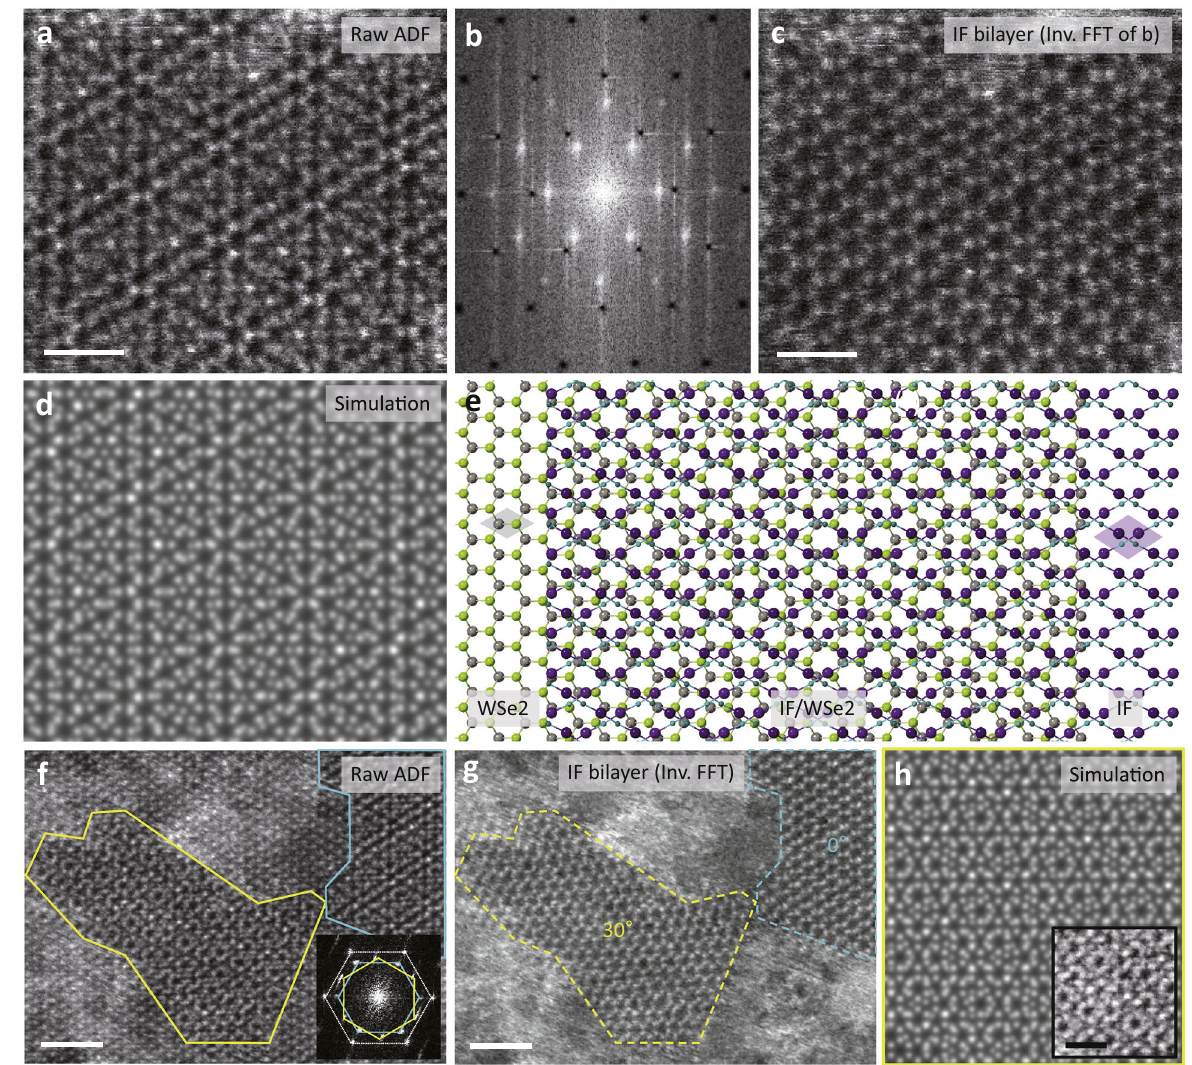
Fig. 3 Structure and stacking order of 2D IF layer on WSe 2 . a The intact ADF image of the IF layer on the WSe 2 substrate. The scale bar is 1 nm. b The masked FFT pattern of a used for the image fi ltering. c An inversed FFT fi ltered image of the IF layer after the contrast from the WSe 2 substrate been removed. The scale bar is 1 nm. d A simulated STEM-ADF image of the atomic models of the IF layer and the substrate. e A top view of the atomic model of IF bilayer on WSe 2 obtained through a DFT calculation. Gray and purple rhombus indicate the unit cell of WSe 2 and IF bilayer. f The ADF image of IF bilayer stacking on WSe 2 with the different rotation angles 0° and 30°. Inset is the corresponding FFT, where the diffraction spots of WSe 2 , the 0°, and 30° rotated IF layers are highlighted by white, cyan, and yellow hexagons. The scale bar